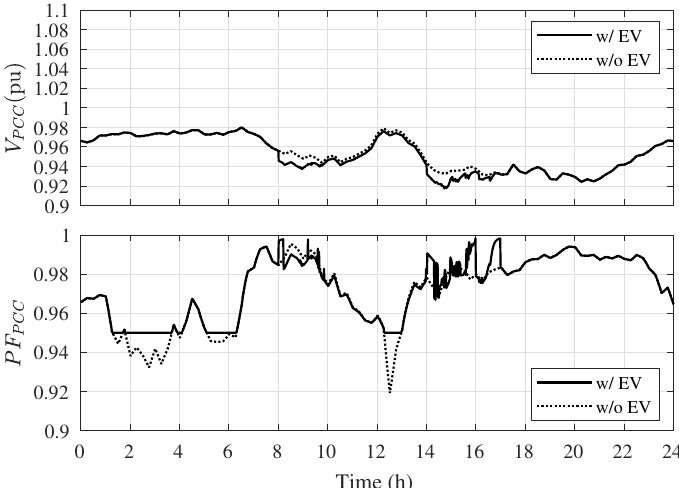
Figure 9. Power factor and voltage at the PCC of the proposed microgrid for scenario